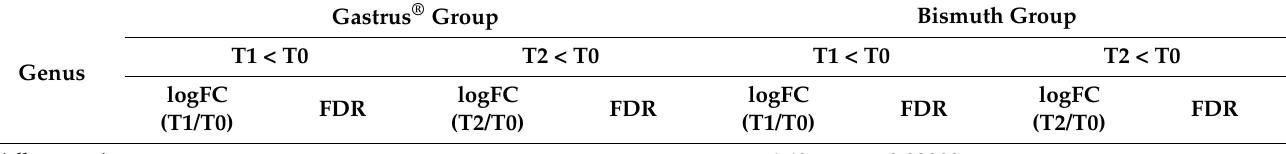
Table 4. List of differential abundant genera when comparing T0 vs. T1 and T2. Genera with statistically significance (FDR < 0.05), identified in at least 50% of the samples in at least one